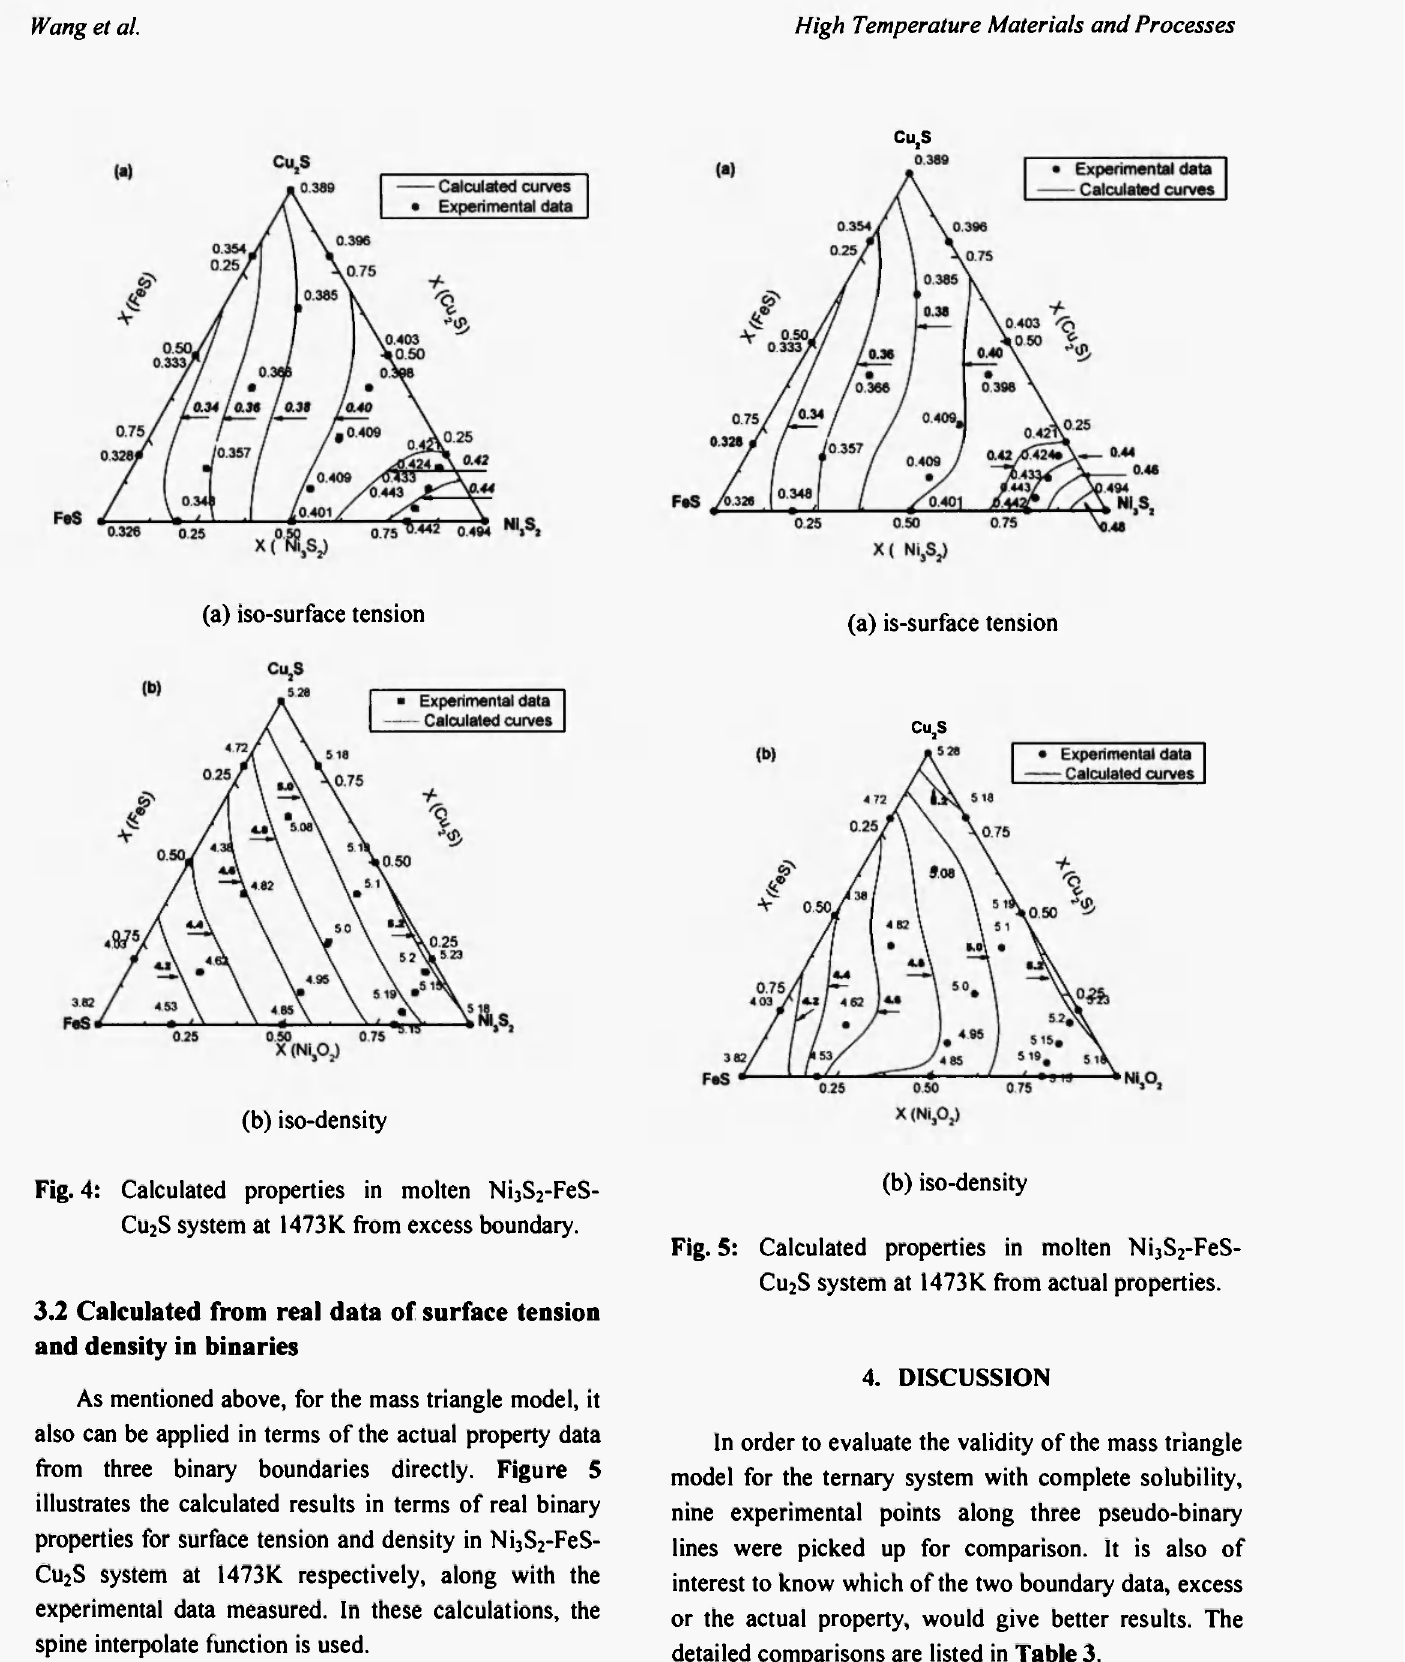
Fig. 5: Calculated properties in molten Ni 3 S 2 -FeS- Cu 2 S system at 1473K. from actual